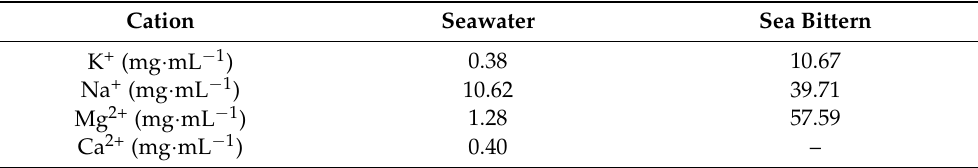
Table 1. Concentration of major cations in seawater and sea bittern. Cation